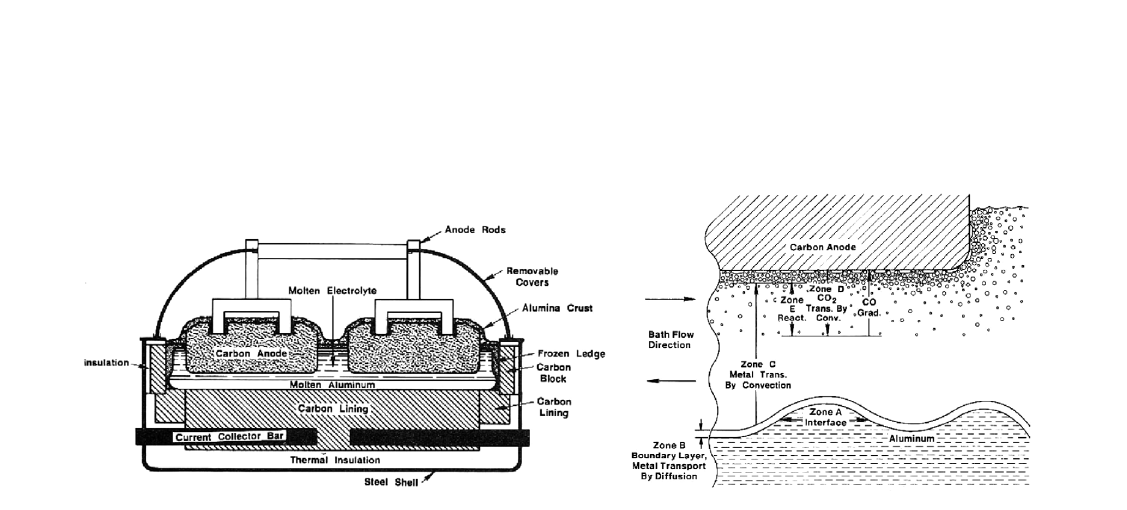
Fig. 12. – Typical cell setup for the Hall-H´eroult process (left) and closeup schematics of the interface regions. Figure adapted with permission from